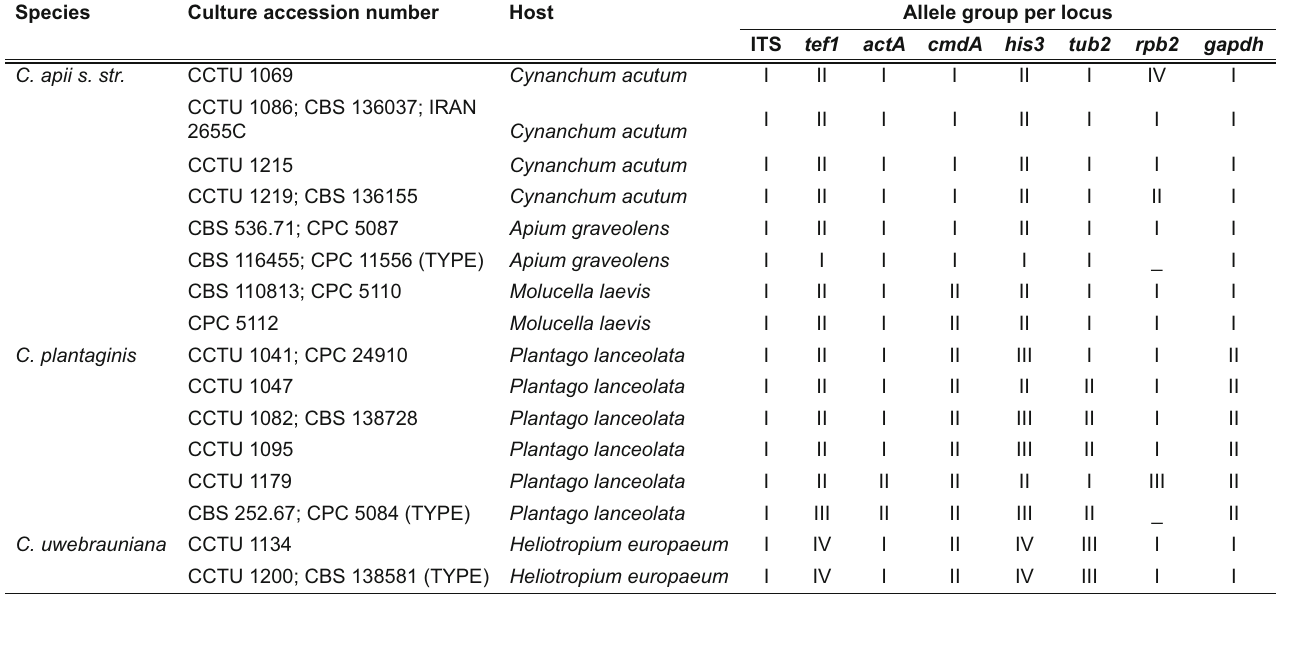
Table 5. (cid:2)G(cid:13)(cid:7)(cid:5)(cid:23)(cid:8)(cid:7)(cid:2)(cid:26)(cid:10)(cid:4)(cid:6)(cid:2)(cid:9)(cid:23)(cid:23)(cid:13)(cid:23)(cid:13)(cid:2)(cid:25)(cid:10)(cid:4)(cid:5)(cid:18)(cid:2)(cid:21)(cid:13)(cid:7)(cid:11)(cid:25)(cid:17)(cid:9)(cid:8)(cid:11)(cid:4)(cid:17)(cid:2)(cid:18)(cid:13)(cid:10)(cid:2)(cid:23)(cid:4)(cid:19)(cid:5)(cid:7)(cid:2)(cid:26)(cid:4)(cid:10)(cid:2) Cercospora apii s. lat. (cid:2)(cid:11)(cid:7)(cid:4)(cid:23)(cid:9)(cid:8)(cid:13)(cid:7)(cid:2)(cid:11)(cid:17)(cid:2)(cid:8)(cid:14)(cid:11)(cid:7)(cid:2)(cid:7)(cid:8)(cid:5)(cid:21)(cid:22)(cid:28)(cid:2)/(cid:12)(cid:12)(cid:10)(cid:13);(cid:11)(cid:9)(cid:8)(cid:11)(cid:4)(cid:17)(cid:7)(cid:2)(cid:4)(cid:26)(cid:2)(cid:23)(cid:4)(cid:19)(cid:11)(cid:2)(cid:9)(cid:17)(cid:21)(cid:2)(cid:19)(cid:4)(cid:23)(cid:23)(cid:13)(cid:19)(cid:8)(cid:11)(cid:4)(cid:17)(cid:2) (cid:9)(cid:19)(cid:19)(cid:13)(cid:7)(cid:7)(cid:11)(cid:4)(cid:17)(cid:2)(cid:17)(cid:5)(cid:6)(cid:12)(cid:13)(cid:10)(cid:7)(cid:2)(cid:26)(cid:4)(cid:23)(cid:23)(cid:4)(cid:15)(cid:2)<(cid:9)(cid:12)(cid:23)(cid:13)(cid:2)!(cid:28) Species